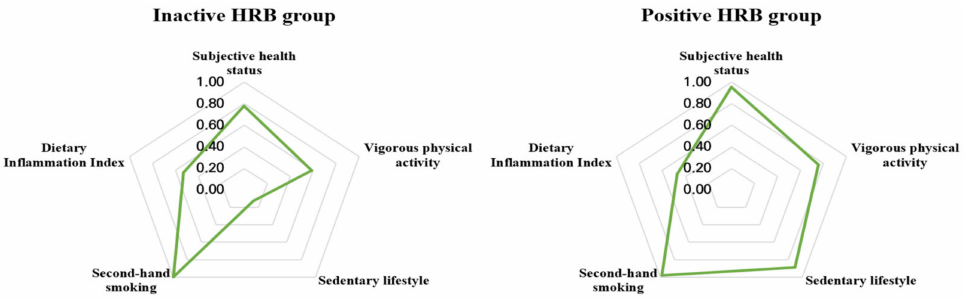
Figure 2. Health-related behavior patterns for each group. HRB, health-related behavior.